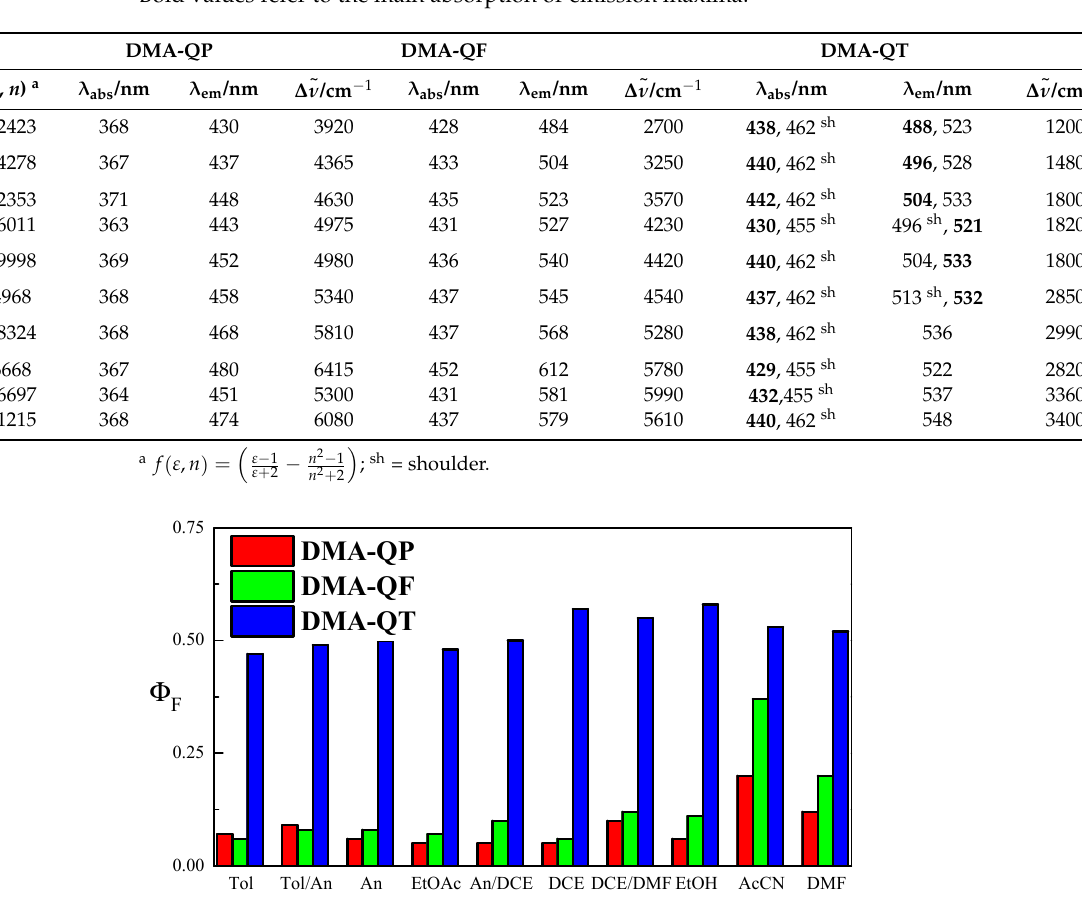
Figure 2. Fluorescence quantum yields of DMA derivatives in solvents of different polarity.